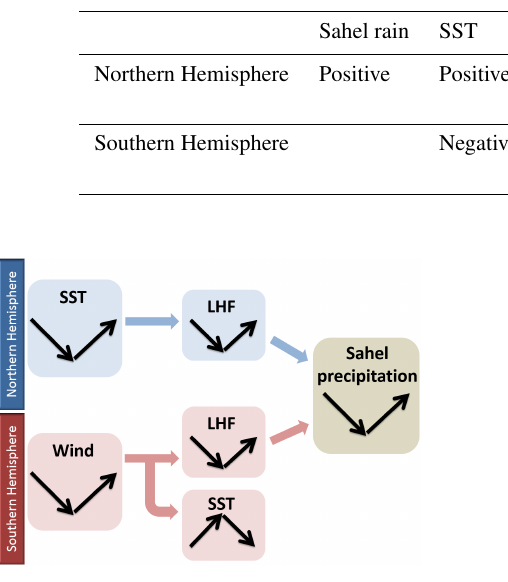
Figure 9. Schematic diagram of possible processes linking Sahel precipitation and the global ocean. The arrows represent increases or decreases in a parameter during 1950–1984 and